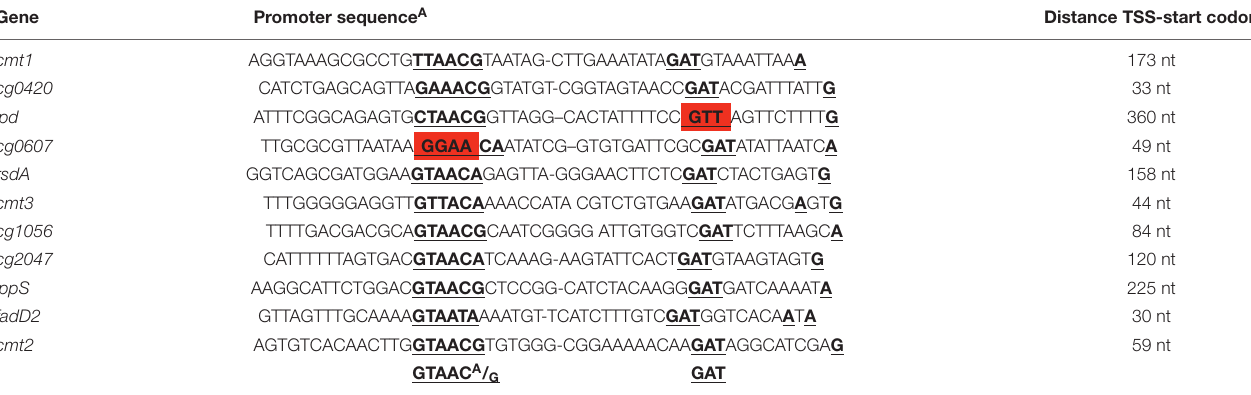
TABLE 2 | Promoter sequences of σ D -dependent genes in C. glutamicum ATCC 13032 determined by RNA sequencing specific for transcription start